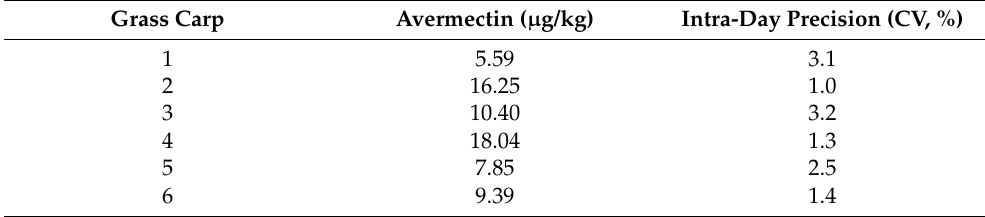
Table 9. Data of real sample analysis (n =